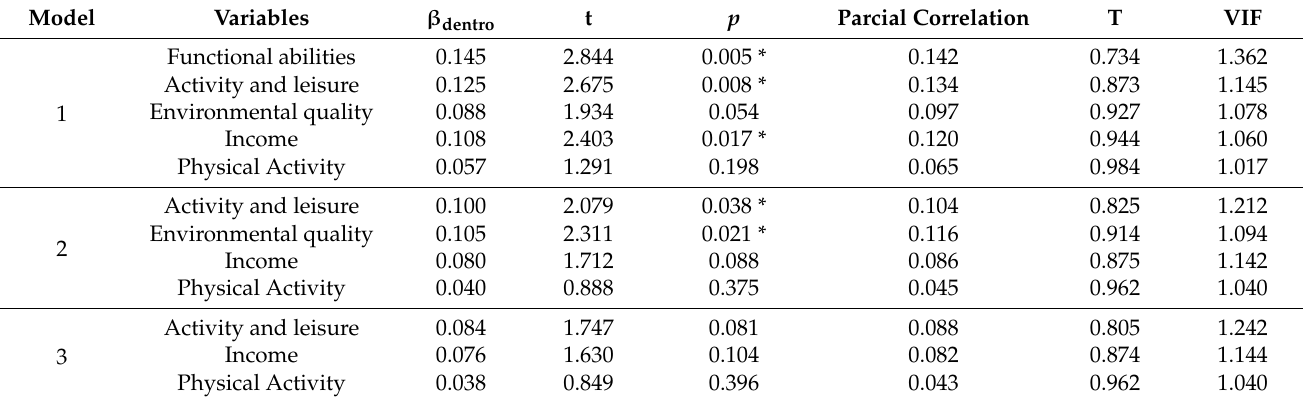
Table 3. Variables excluded from the regression